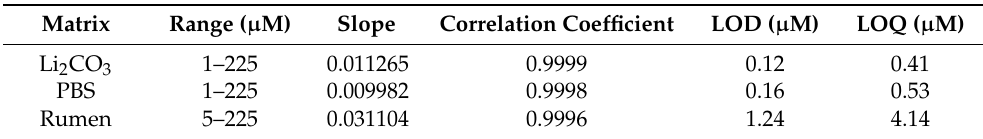
Table 2. Regression analysis of calibration curves, detection limit and quantification limit in Li 2 CO 3 buffer, phosphate buffered saline buffer, and rumen inoculum ( n = 3). Matrix Range ( µ M) Slope Correlation Coefficient LOD ( µ M) LOQ ( µ M) Li 2 CO 3 1–225 PBS 1–225 Rumen